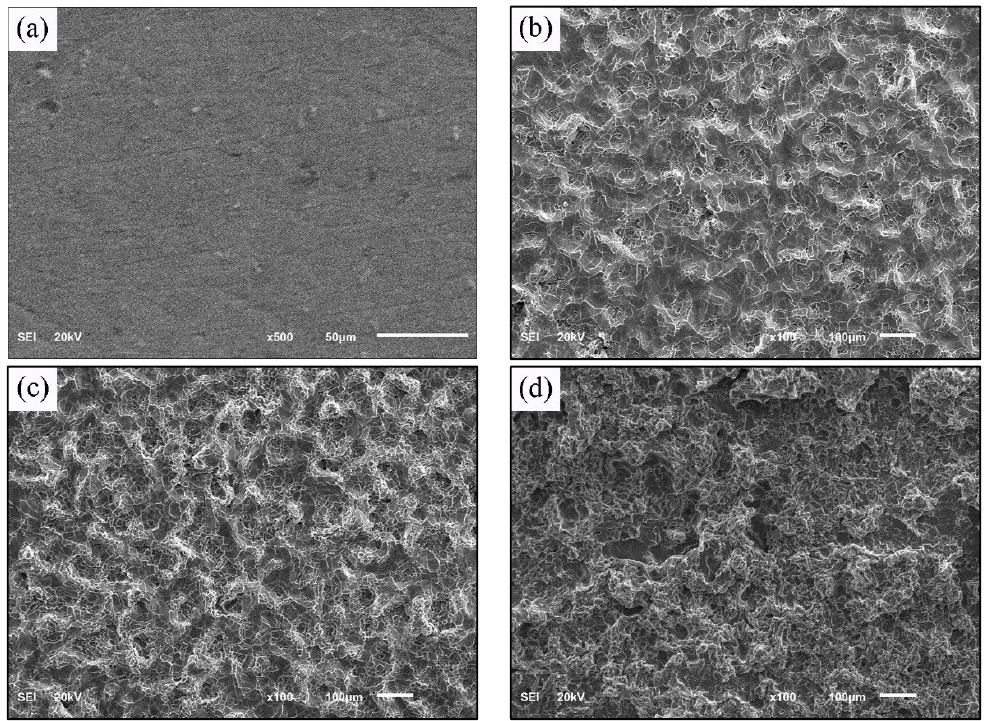
Figure 3. The damaged area of the Al alloy specimen after different test times. ( a ) before test; ( b ) after 3 min test; ( c ) after 6 min test; ( d ) after 10 min test.